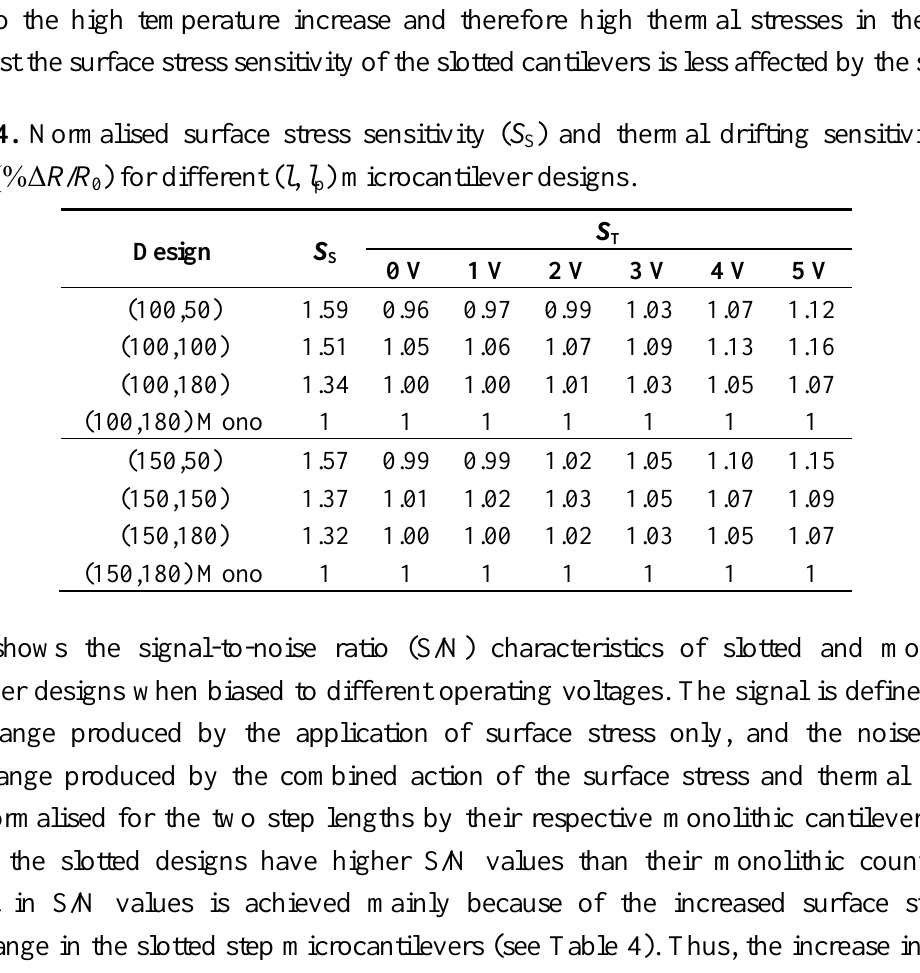
) microcantilever designs. p